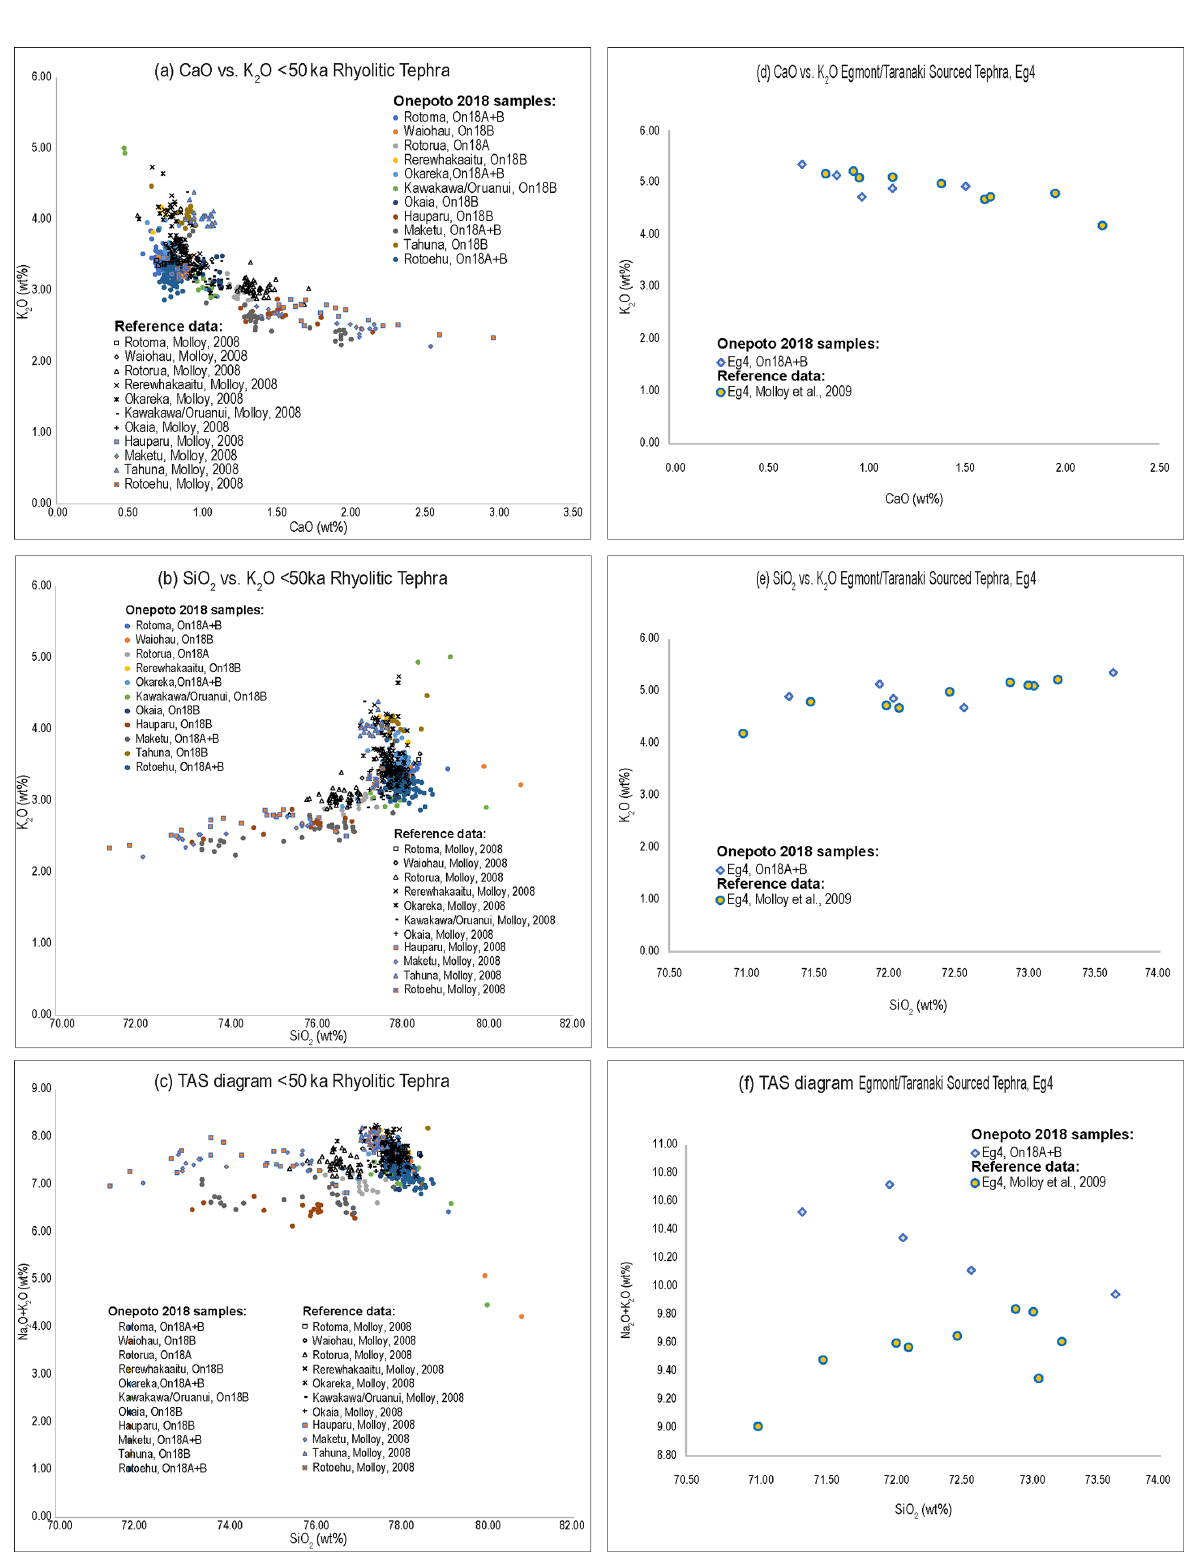
Figure 6. Glass shard major-element oxide bivariate plots of reference glass tephra data (taken from Molloy, 2008) and Onepoto (2018 drilling)